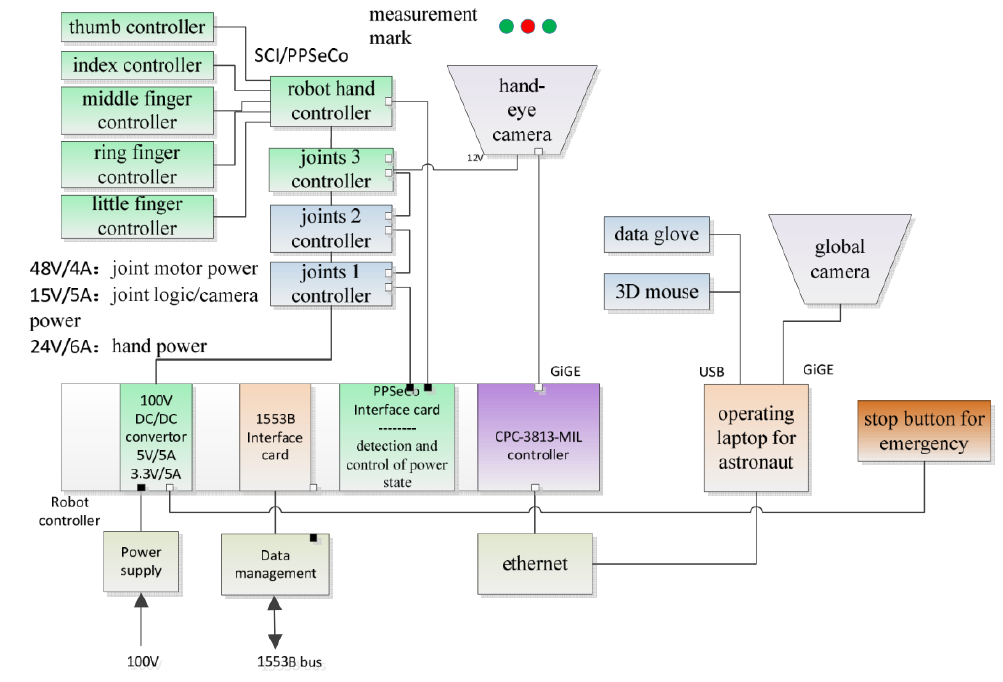
Figure 6. System control block